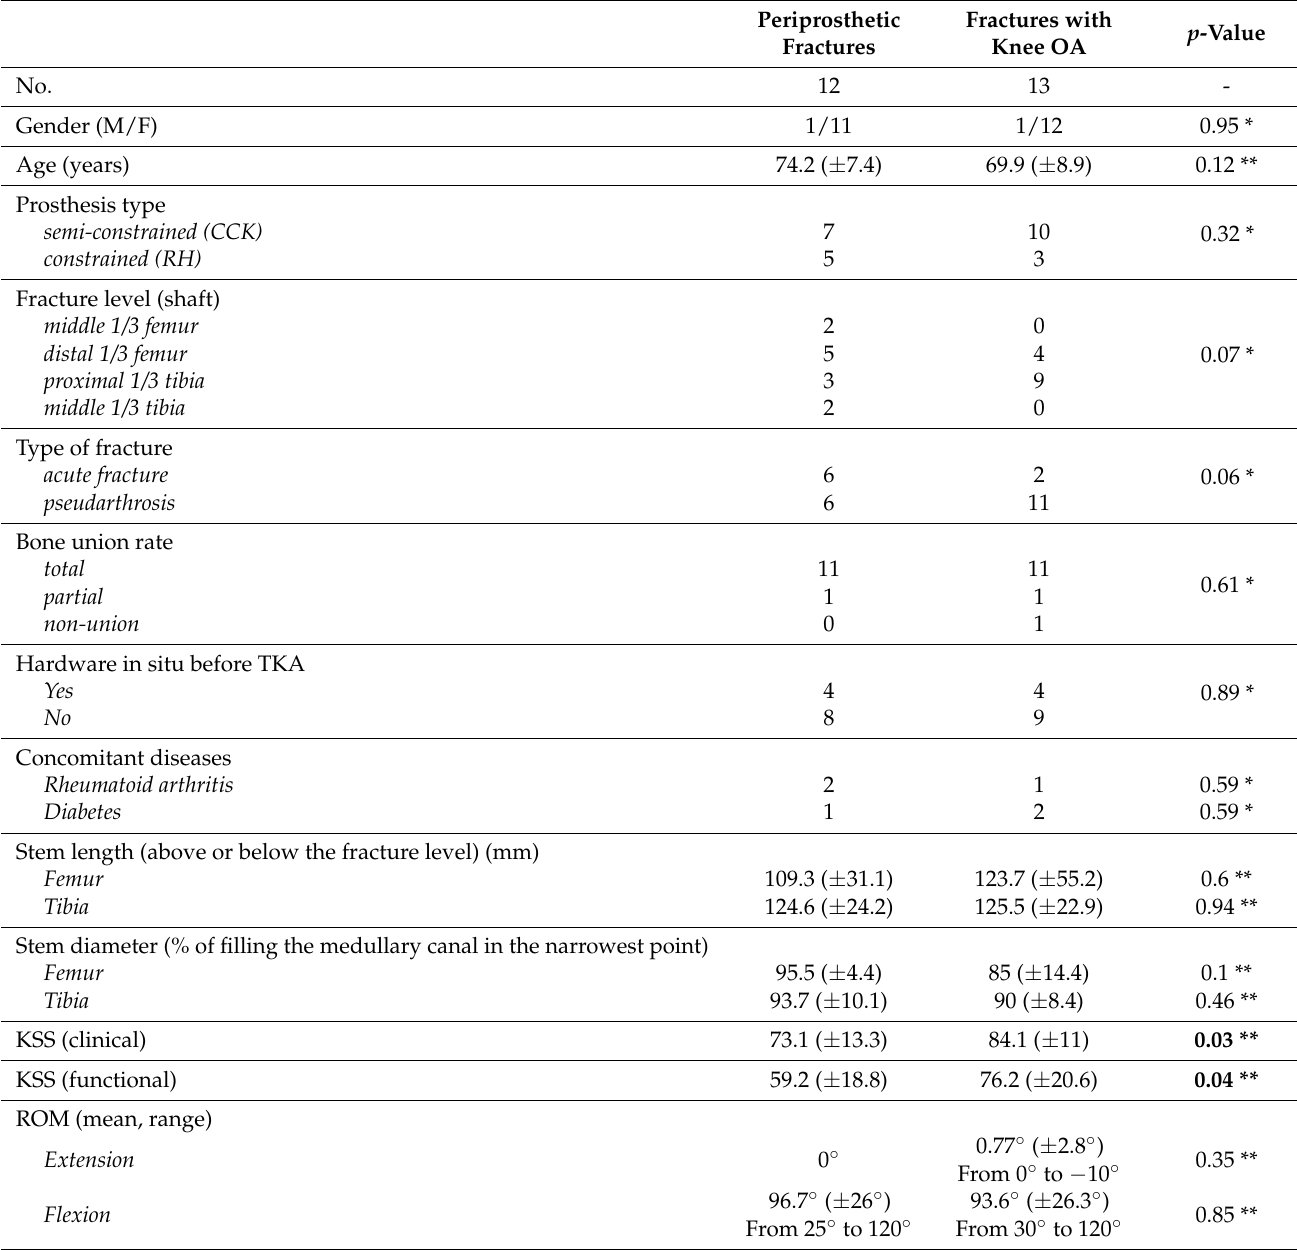
Table 2. Demographic and clinical data in the analyzed sub-groups of patients. Continuous variables are presented as means ( ± SD).